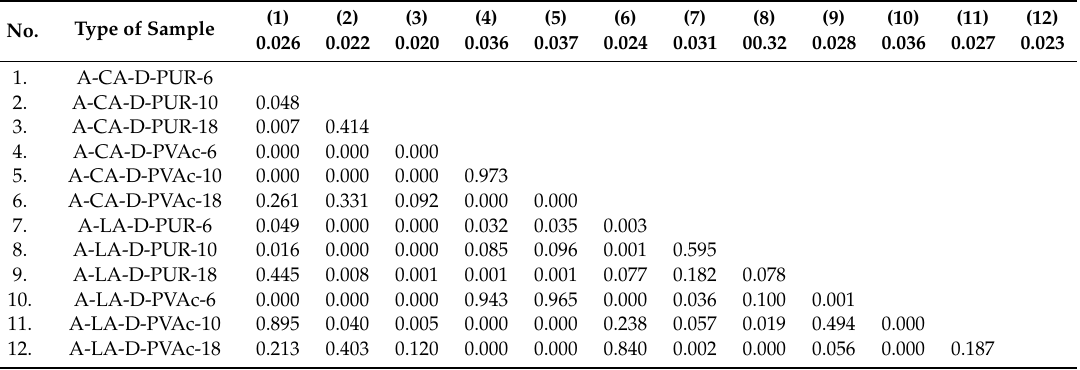
Table 19. Comparison of the e ff ects of individual factors using Duncan’s test on the coe ffi cient of bendability ( K bendC ) for aspen and NWC on the